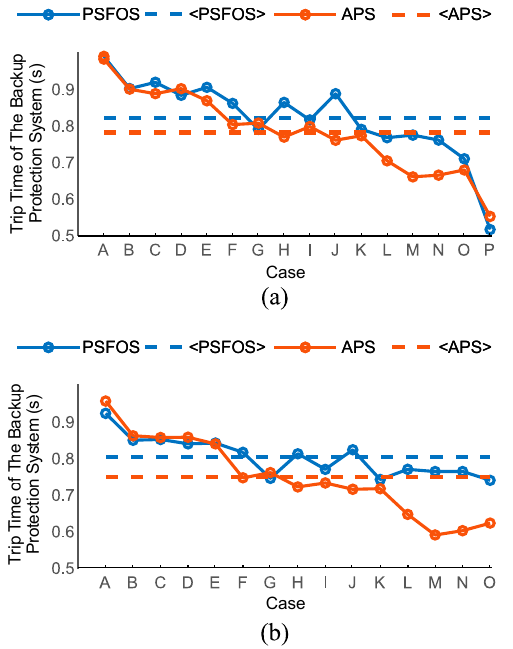
Figure 5. Average trip times of the backup protection system: ( a ) grid-connected mode, ( b ) islanded mode.